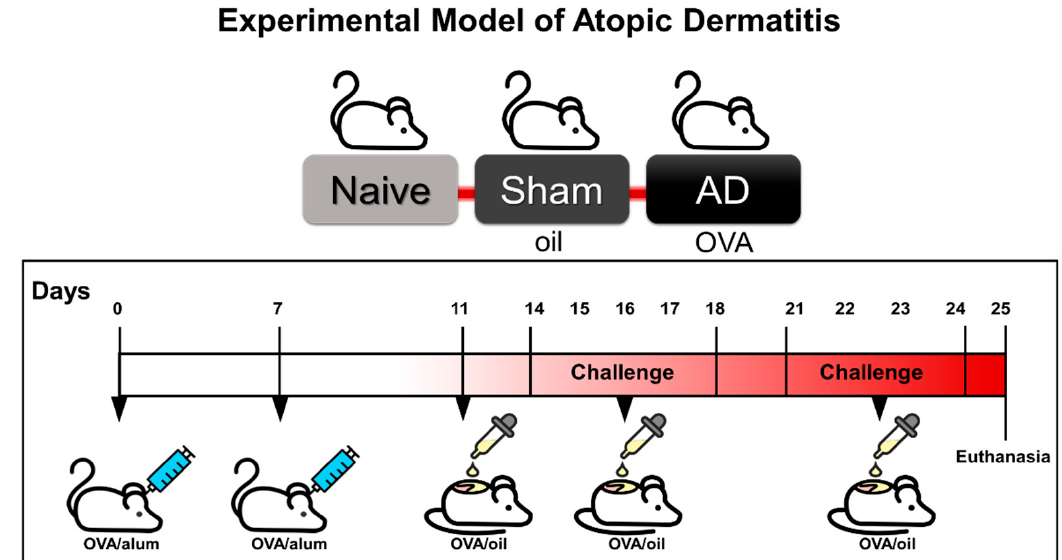
Figure 1. Experimental model of atopic dermatitis (AD). On days 0 and 7, male BALB/c mice were immunized with a subcutaneous injection of 5 µg of ovalbumin (OVA) and 10 mg/mL of the aluminum hydroxide adjuvant (alum). On days 11, 14 to 18, and 21 to 24, dorsal shaved flanks of animals were challenged with 250 µg of OVA diluted in 50 µL of Johnson’s Baby ® oil. Sham animals received only sterile saline (days 0 and 7) and oil (days 11, 14–18, 21–24), while the naive group was only manipulated. After 24 h of the last OVA challenge, animals were euthanized for skin analysis.